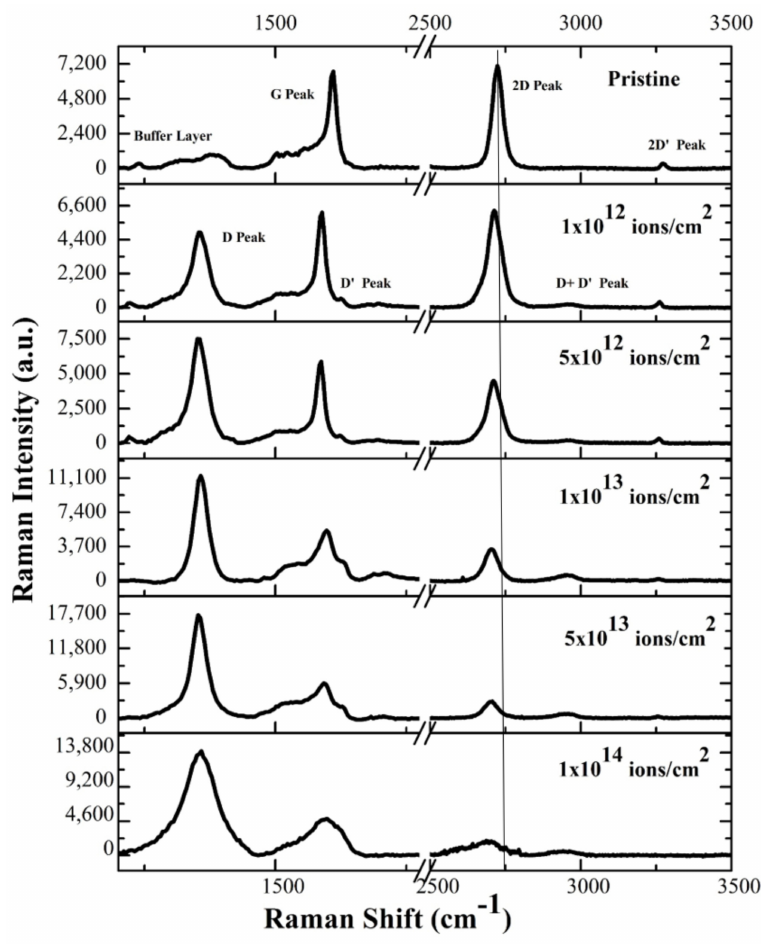
Figure 2. Raman spectra of pristine and N + ion-implanted EG on SiC obtained at di ff erent